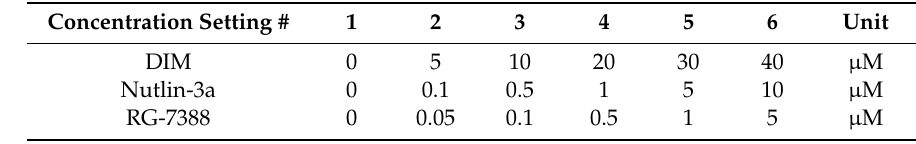
Table 1. Combination of DIM and MDM2 antagonists.